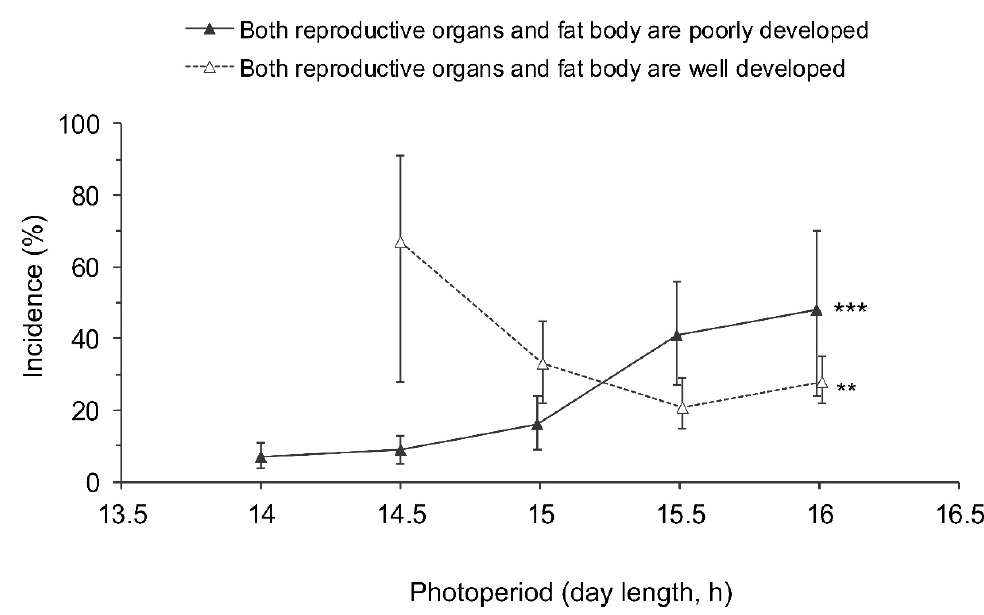
Figure 7. Effect of day length on the incidence of Halyomorpha halys adults with poorly developed reproductive organs and fat bodies (among the individuals with poorly developed reproductive organs) and those with well developed reproductive organs and fat bodies (among the individuals with well developed reproductive organs). Percentages and 95% confidence intervals for the pooled data for males and females from all populations are shown ( n = 12–297 per treatment). Asterisks at the right end of the graphs indicate significant difference between the data for different photoperi- ods, i.e., significant photoperiodic response (** – p < 0.01, *** – p < 0.001 by the Chi-square test). Some symbols are slightly shifted along the x-axis to avoid overlap.